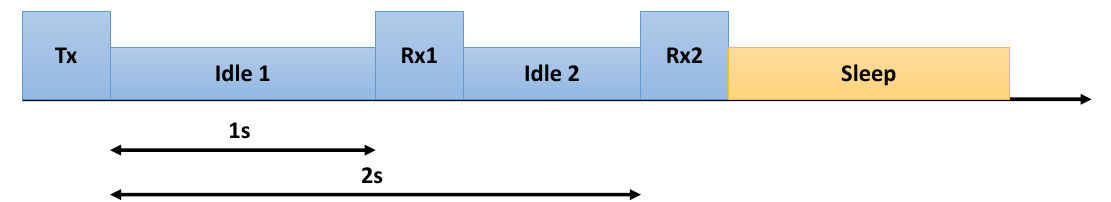
Figure 5. LoRaWAN Class A device window